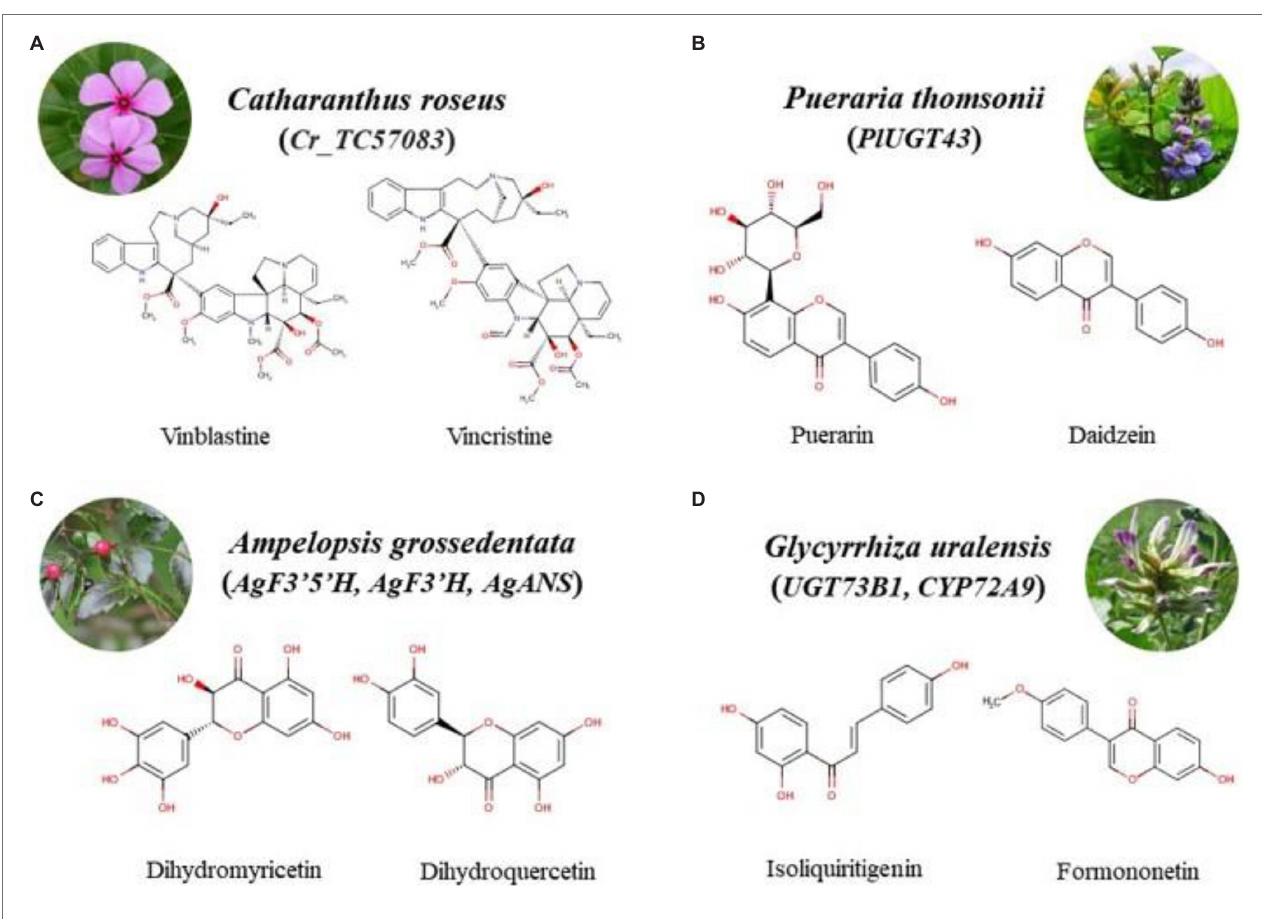
FIGURE 2 | Chemical structure formula of the bioactive compounds from four species. *Bioactive compound-related functional genes are shown in the brackets. (A) Cr_TC57083, the functional gene related to synthesis of vinblastine and vincristine in Catharanthus roseus ; (B) PlUGT43, the functional gene involved in synthesis of puerarin and daidzein in Pueraria thomsonii ; (C) AgF3’5’H, AgF3’H, AgANS, the functional genes associated with biosynthesis of dihydromyricetin and dihydroquercetin in Ampelopsis grossdentata ; (D) UGT73B1, CYP72A9, the functional genes correlation with synthesis of isoliquiritigrnin and formononetin in Glycyrrhiza uralensis